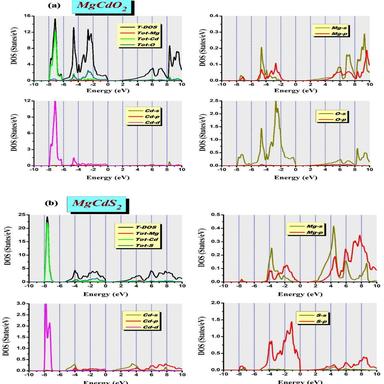
Calculated total and partial density of states for (a) MgCdO2 and (b) MgCdS2 respectively.